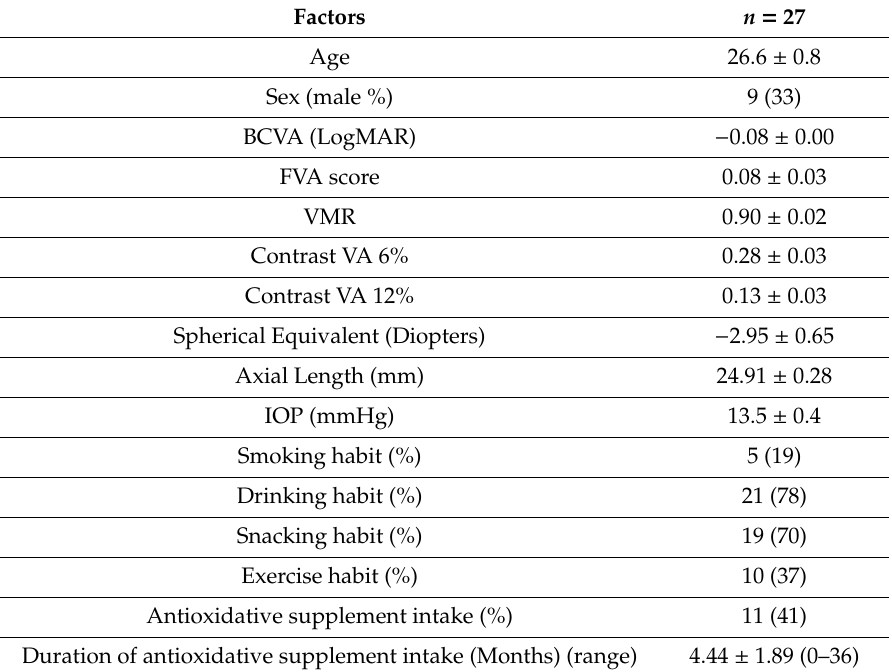
Table 1. Characteristics of the